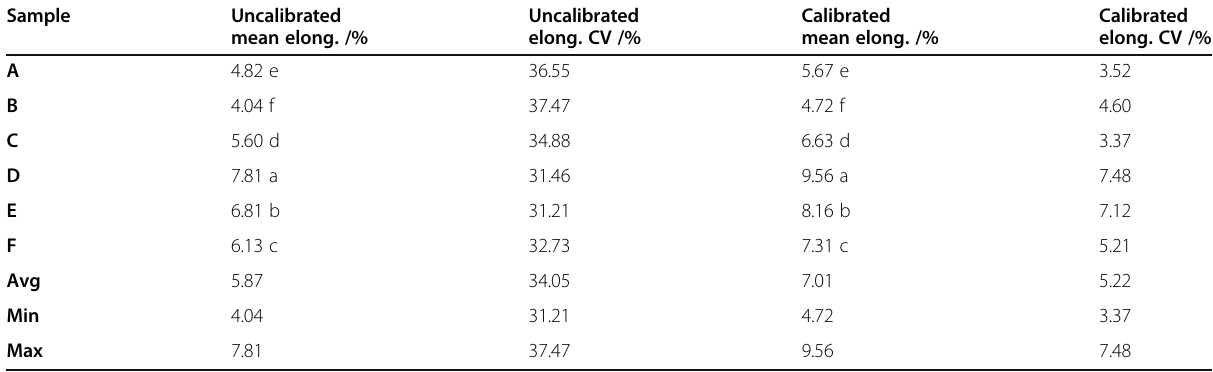
Table 6 Elongation variance across HVI instruments